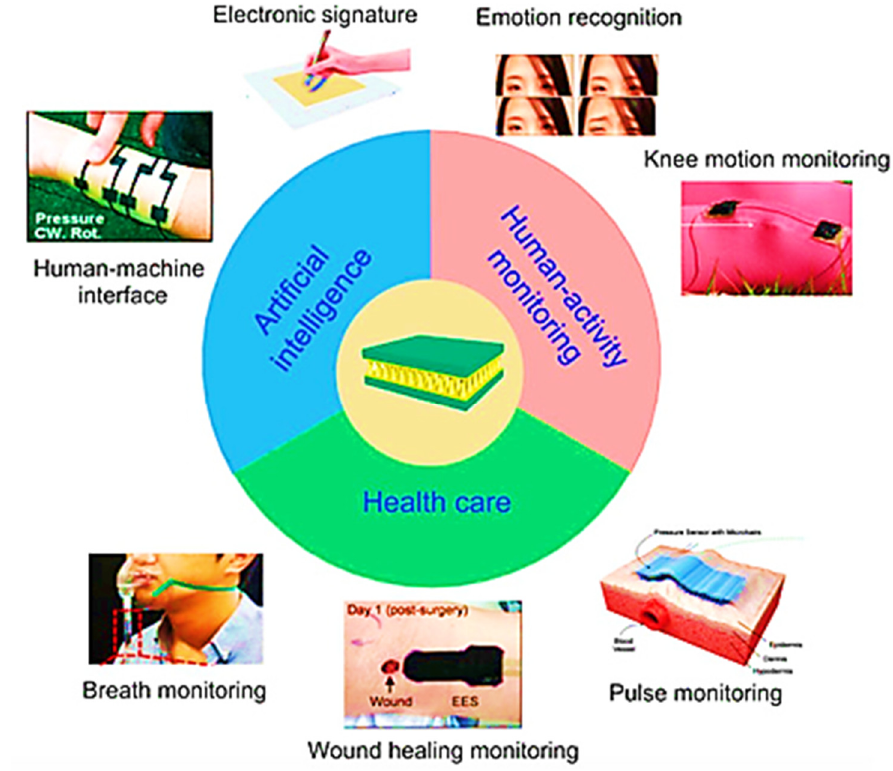
Figure 1. The main parts of a flexible sensor comprise flexible materials and applications [16]. Copyright 2017, Elsevier.